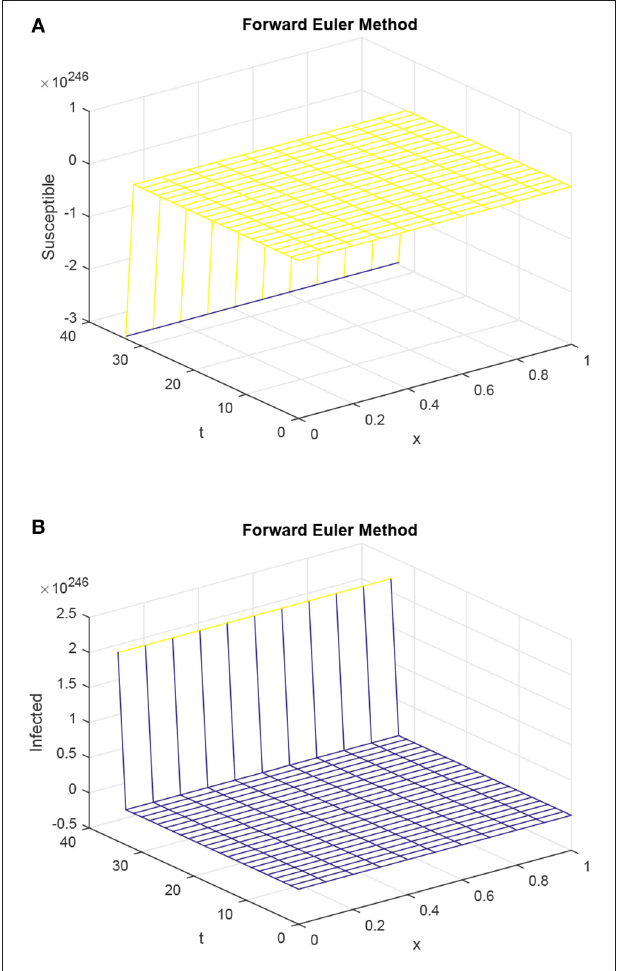
FIGURE 3 | Graphs of susceptible population and infected population using Euler method for forward difference, with h = 0.1 and R 1 = R 2 = 0.15, τ = 1.5. (A) Mesh graph of S . (B) Mesh graph of I .